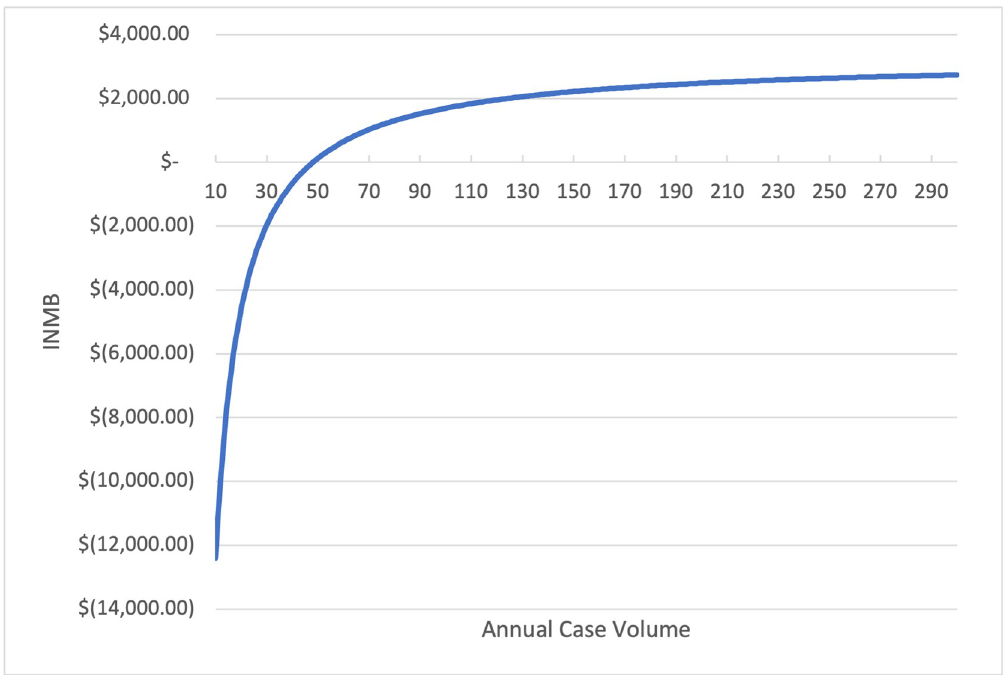
Fig 2. Annual case volume and INMB of robotic-arm assisted TKA. Abbreviations : INMB: incremental monetary net benefit; TKA: total knee arthroplasty. Note : The INMB willingness-to-pay (WTP) threshold was assumed to be $50,000 per QALY. INMB was calculated as incremental QALYs × WTP − incremental costs. Robotic-arm assisted TKA was cost-effective when case volume exceeded 49 cases per year.